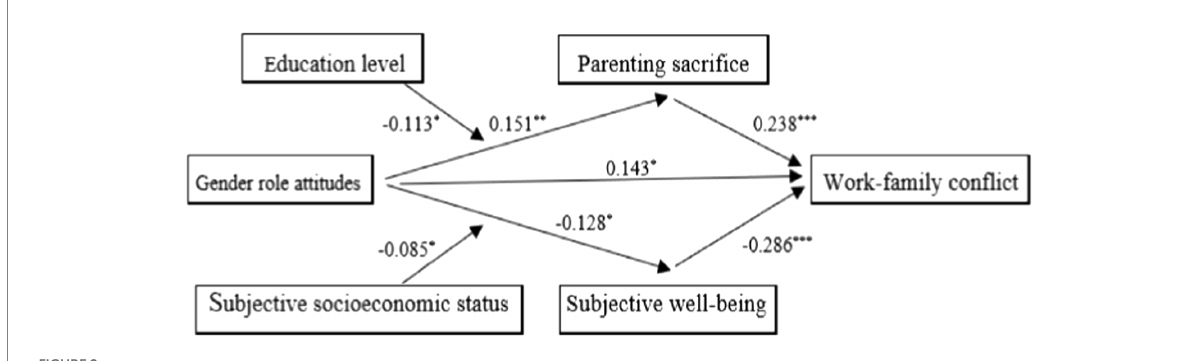
FIGURE 2 A multiple mediating model including moderated mediation analysis.